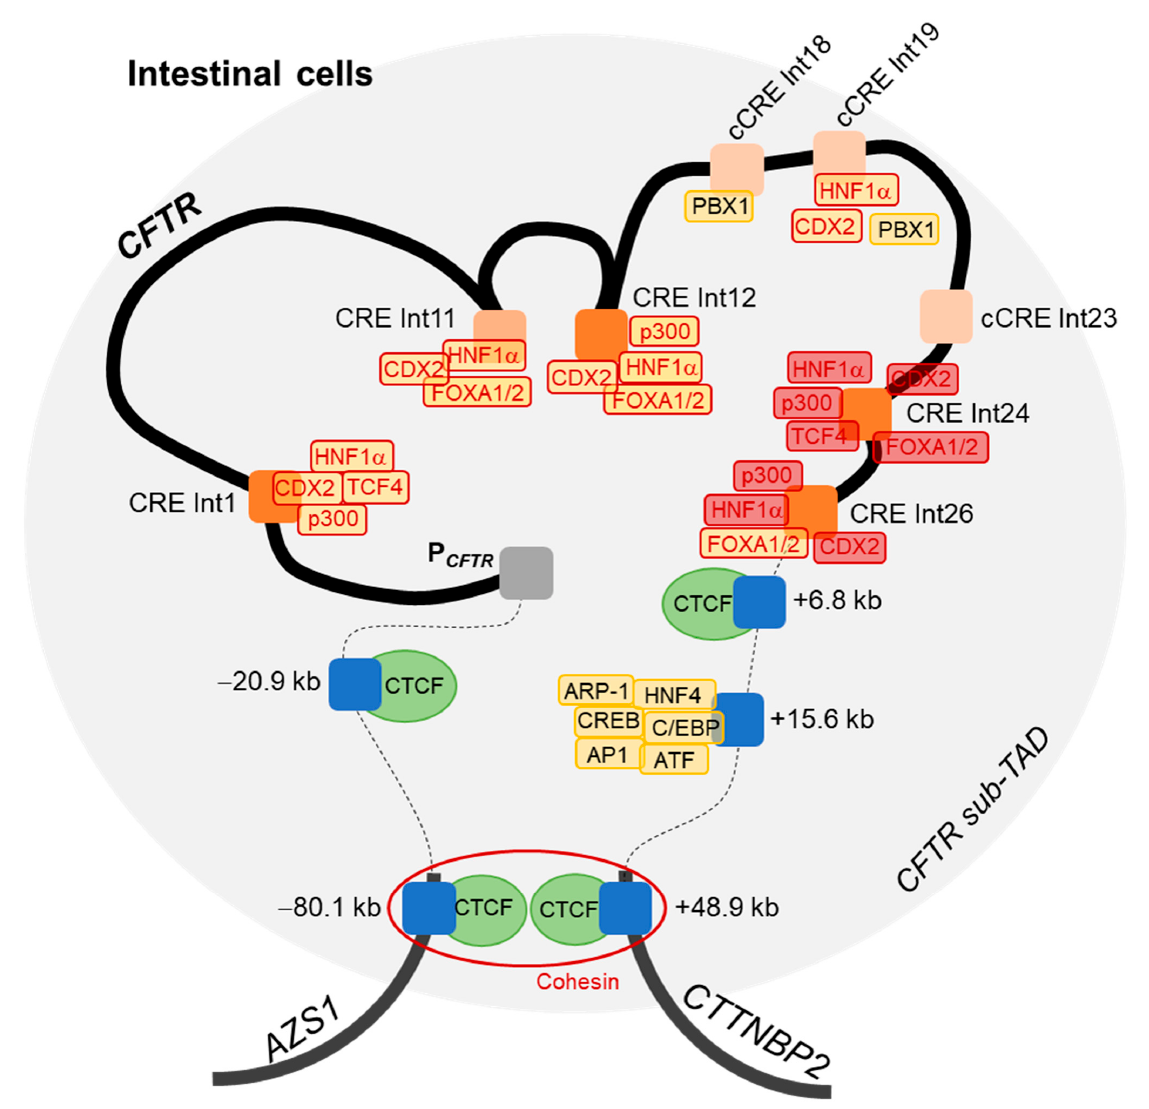
Figure 6. Model of three-dimensional regulation of the CFTR locus in intestinal cells. A DNA loop is formed by the recruitment of CTCF factors at − 80.1 kb and +48.9 kb of the CFTR gene, in complex with cohesin (red ring), delineating boundaries of the topologically associated domain (TAD) of the CFTR locus (blue rectangles representing the barrier insulators and the red circle representing the cohesin). DNA loops and binding of transcription factors (TFs) (yellow blocks) allow the proximity of DNase hypersensitive sites (DHSs) present in introns (Int) and described as enhancers (orange blocks) with the promoter (P CFTR ). Blue blocks represent insulators located upstream or downstream of the CFTR gene. Dark orange blocks correspond to our intronic regions of interest, whereas light orange blocks have been previously re- ported but not studied in this work. TFs with red contours correspond to factors of interest, such as HNF1 α , p300, FOXA1, FOXA2, CDX2 and TCF4, which have been studied for their binding with introns 24 and 26 (block filled with red).